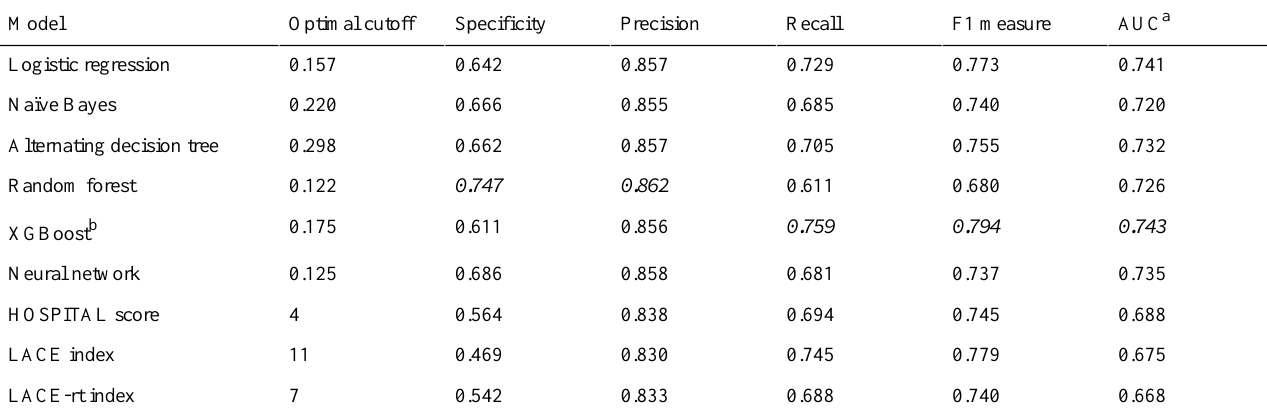
Table 4. Performance of the candidate models and baseline models on the validation set. The best-performing parameters are indicated in italic